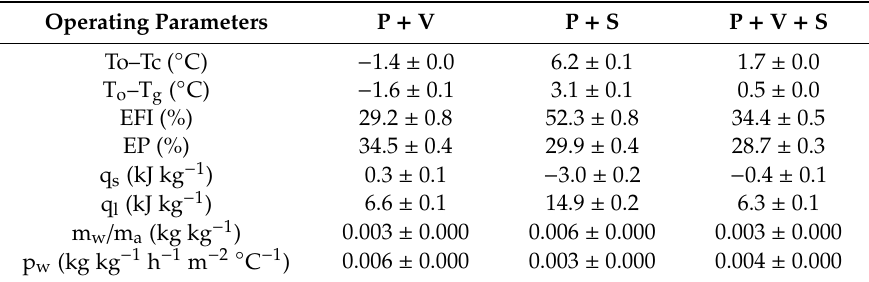
Table 5. Average values and standard deviation of the di ff erent fan-pad system operating parameters. The tests analysed are the fan-pad system (P) together with roof ventilation (P + V, test 6), with shading (P + S, test 7) and with both (P + V + S, test